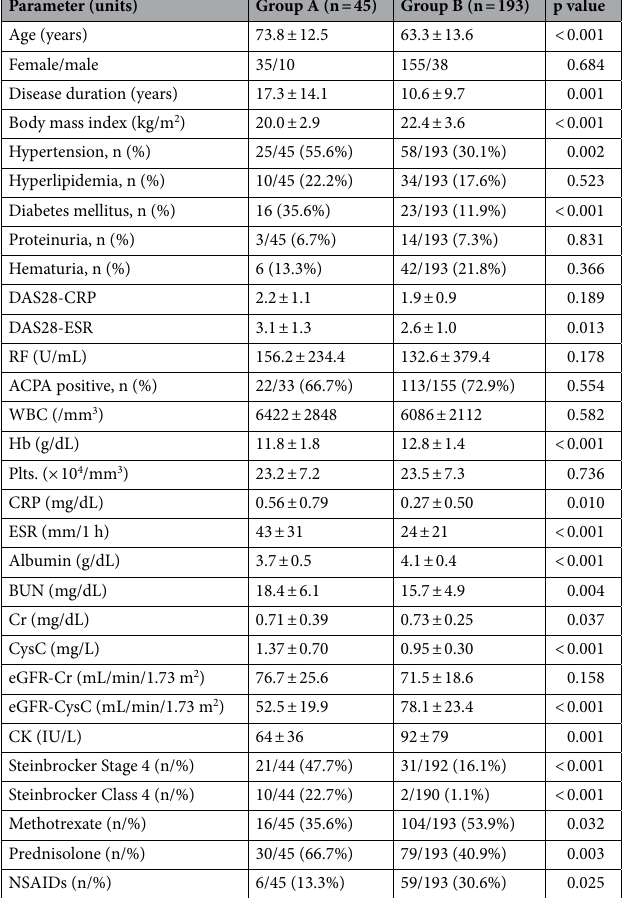
Table 2. Differences in parameters between Group A and Group B. Group A eGFR-Cr/eGFR-CysC ≥ 1.2, Group B eGFR-Cr/eGFR-CysC < 1.2), DAS-CRP disease activity score, using the 28-joint count and C reactive protein, DAS-ESR disease activity score, using the 28-joint count and erythrocyte sedimentation rate, CDAI clinical disease activity index, SDAI simple disease activity index, RF rheumatoid factor, ACPA anti-cyclic citrullinated peptide antibody, eGFR-Cr estimated glomerular rate using creatinine, eGFR-CysC estimated glomerular rate using cystatin C.